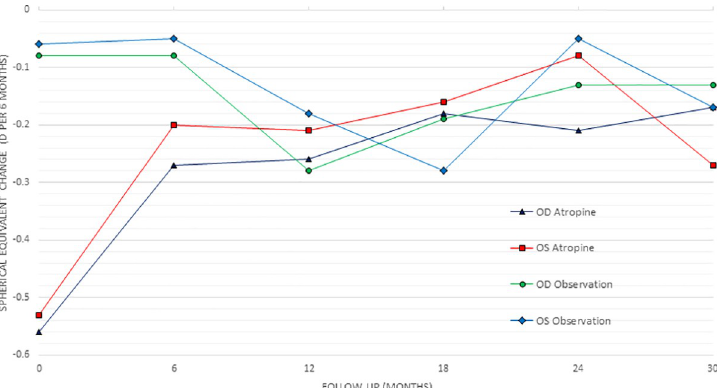
Fig 3. Graph showing change in the spherical equivalent in the observation and atropine 0.01% group over each six months.